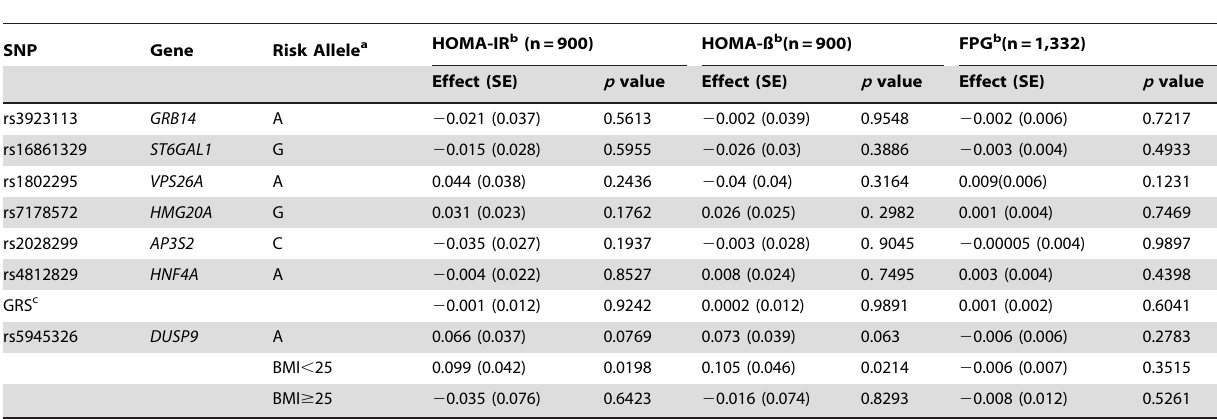
Table 4. Association of 7 SNPs with quantitative traits related to glucose metabolism in controls.